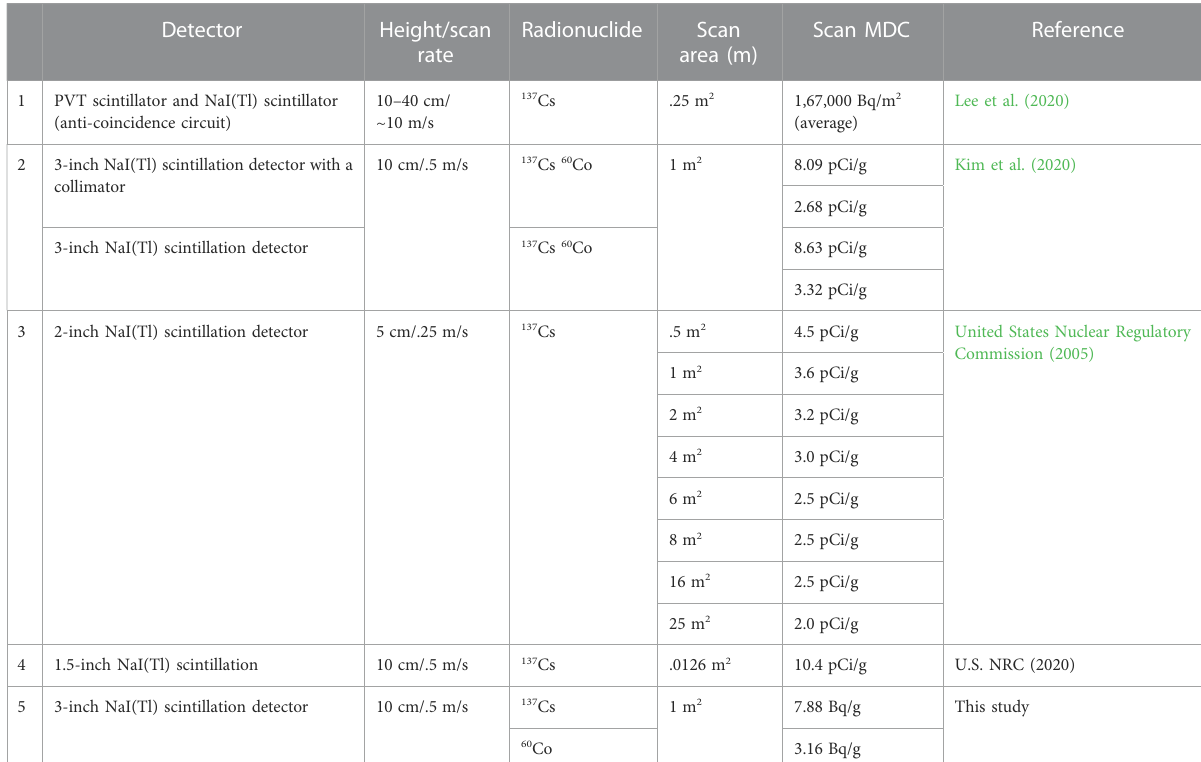
TABLE 1 Case study for the SCAN MDC